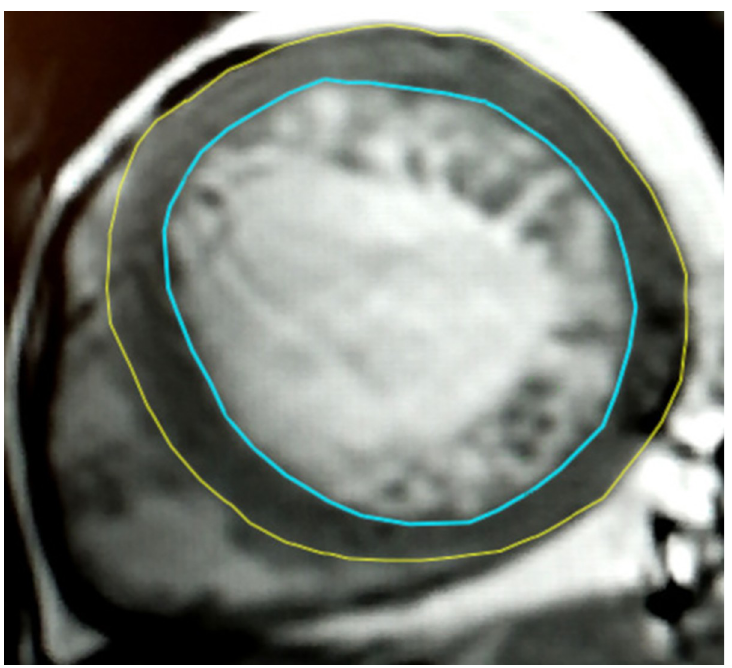
Fig 2. Diagnostic scheme of a noncompacted layer mass (NCM) assessment by Hautvast’s computed algorithm method. Contours: epicardial (yellow), endocardial (blue); the left ventricular compacted layer is between the epicardial (yellow) and endocardial (blue) contours, and the noncompacted layer is inside the space delimited by the endocardial (blue) contour, and its mass is calculated automatically by Hautvast’s computed algorithm. and OBSERVER DEPENDENTLY (iii) PMs. LVM was calculated, adding NCM J follows: LVM = NCM + CLM J J J. The estimate of CLM , NCM , NCM /LVM . According to Hautvast’s computed H H H H algorithm, only two contours were traced in all slices of the LV short-axis view in end-diastole (Fig 2): i. the epicardial